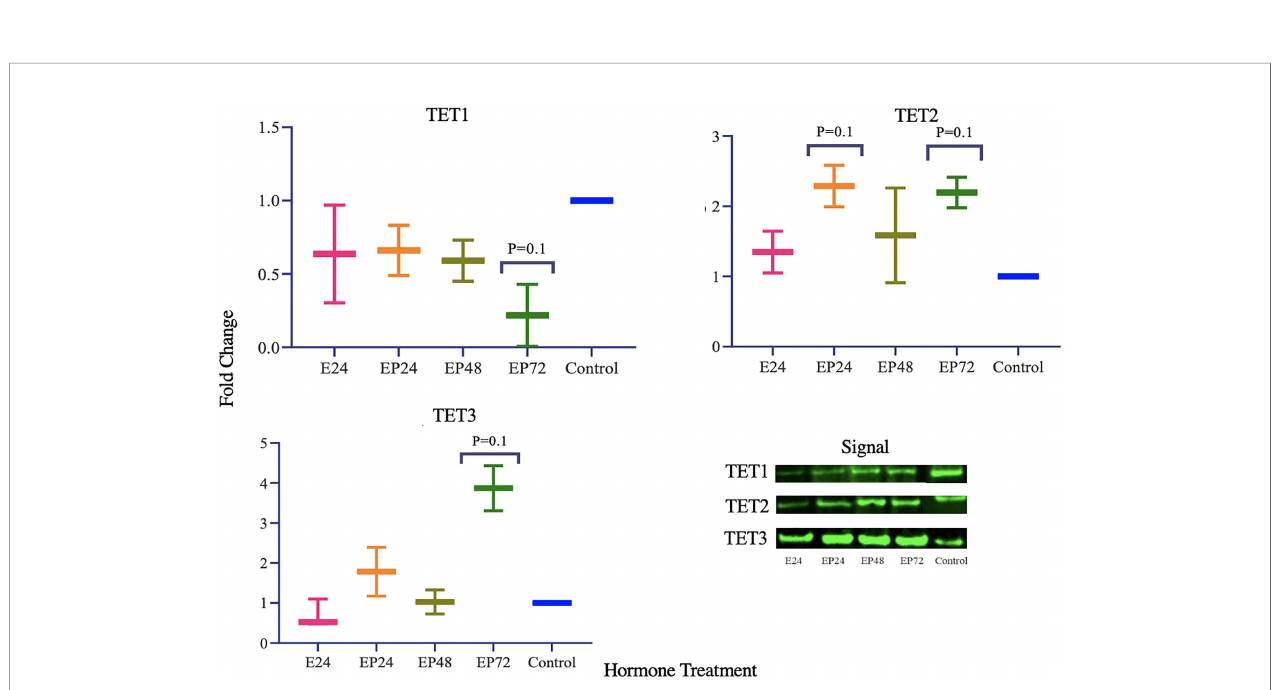
FIGURE 2 | TET protein expression in response to different steroid hormone treatments in AN3 cells. A representative blot image for the particular weight band is shown next to the graph. The y-axis shows the fold change of protein levels following different treatments compared to control and x-axis shows the different treatment groups. E24, 24h Estrogen; EP24, EP48 and EP72 = both Estrogen + Progesterone for 24, 48 and 72h. Data are presented as mean ± SEM, *p < 0.05 (P ≤ 0.1 is considered as approaching signi fi cance). The experimental setup included three independent sets of cell culture experiments (n = 3) with three technical replicates for each sample.